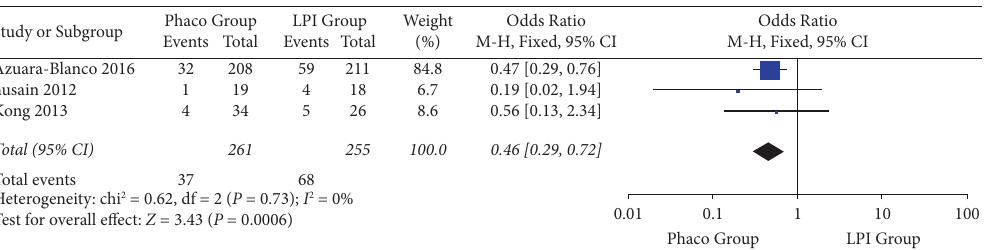
Figure 5: Te forest plot comparing the numbers of complications between the Phaco groups and LPI groups.